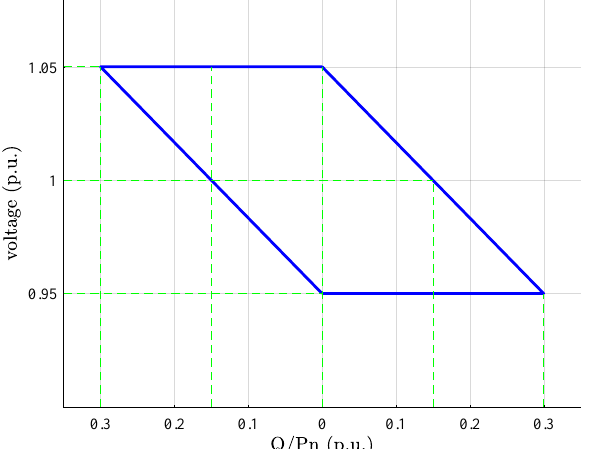
Figure 12. Basic requirements on the supply of reactive energy from renewable plants according to the Spanish grid code. The region limited by the line in blue represents the area of reactive power regulation for continuous voltage